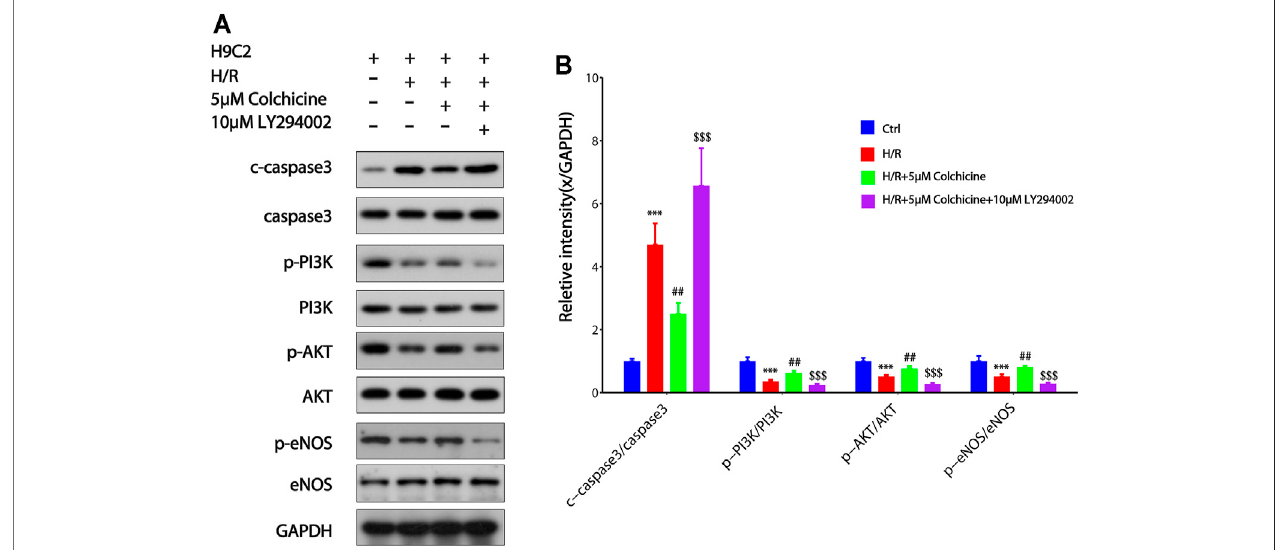
FIGURE10| Colchicine inhibited MIRI-induced apoptosis ofH9C2 byregulating thePI3K/AKT/eNOS pathway. (A) Protein expression ofp-PI3K, p -AKT, p -eNOS, and Caspase-3 were detected by western blot analysis; (B) Protein content was quanti fi ed using densitometric analysis with GAPDH as internal control. The values of controlgroupweresetasone.Datawereexpressedasmean ± SD(*** p < 0.001comparedwithcontrol;## p < 0.01comparedwithH/Rgroup;$$$ p < 0.001compared with colchicine treated